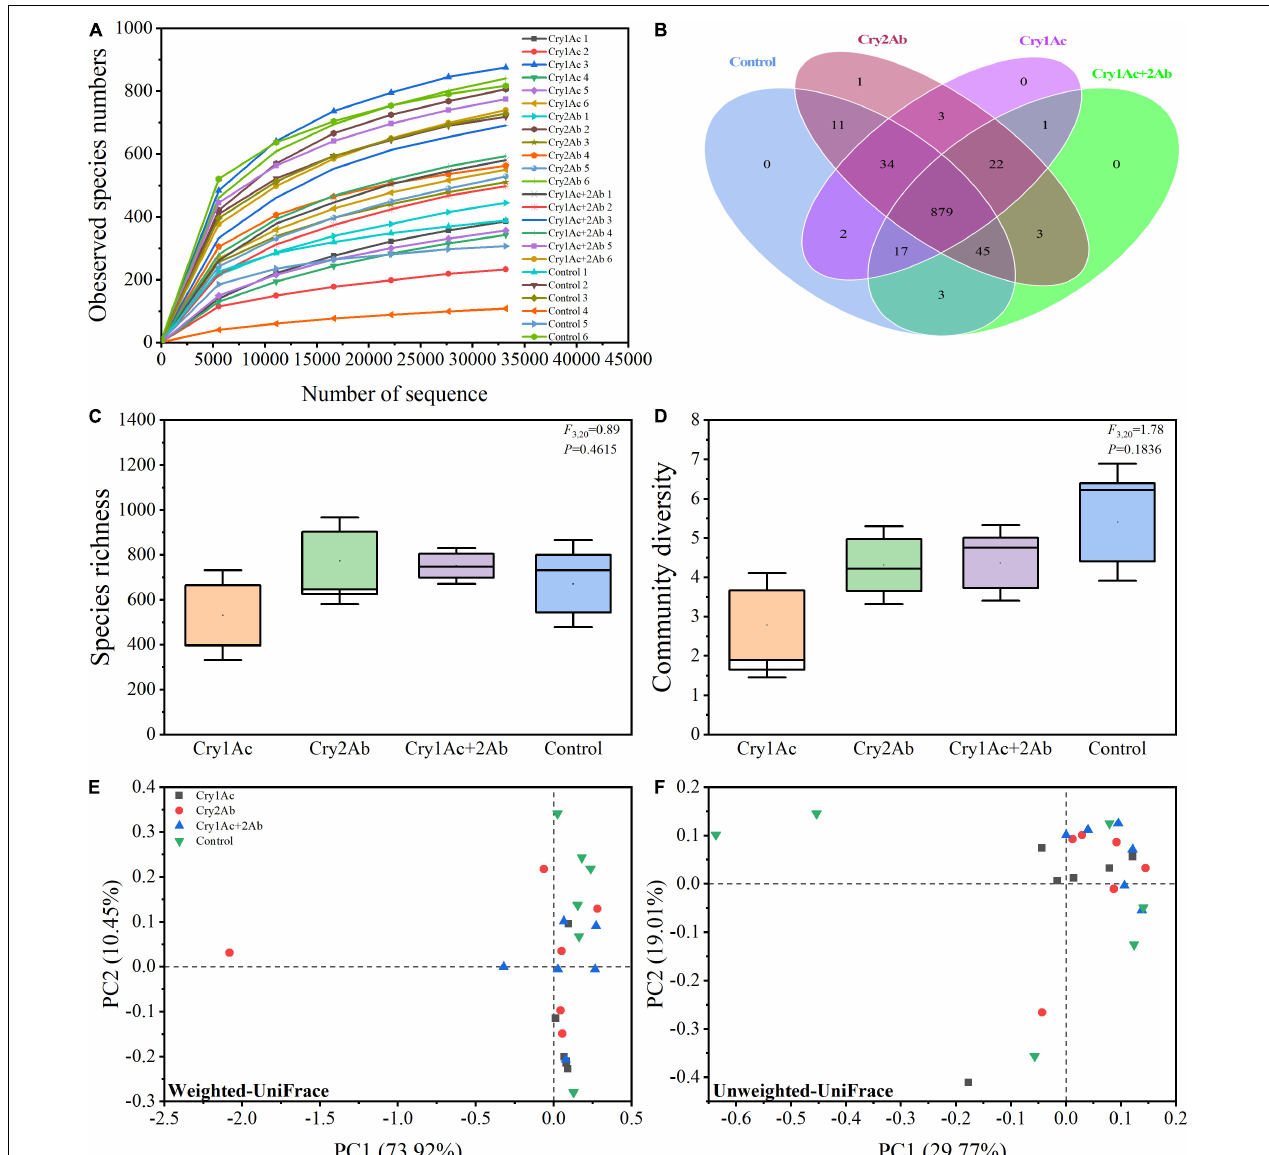
FIGURE 1 | Bacterial diversity of P. japonica in response to consumption of Bt toxins. (A) Rarefaction curves based on species abundance data. Venn diagram (B) illustrating the number of bacteria shared and unique across four treatments. Boxplot of species richness (number of OTUs) (C) and community diversity measured by the Shannon index (D) . Different lowercase labels above each group indicate significant differences (one-way ANOVA, Tukey’s HSD test, P < 0.05) of group mean value. Principal coordinate analysis (PCoA) plot visualizing the data based on β -diversity metrics of weighted UniFrac (E) and unweighted UniFrac (F) distance. The percentage of variation explained by each axis refers to the fraction of the total variance of the data explained by the constrained